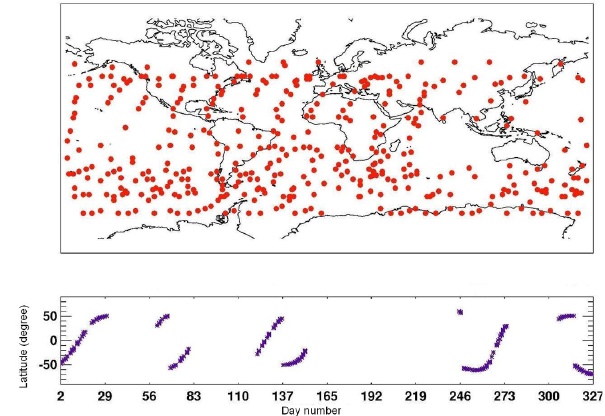
Fig. 2. Location of the simulated dataset (upper panel) and latitude (degree) vs. time (lower